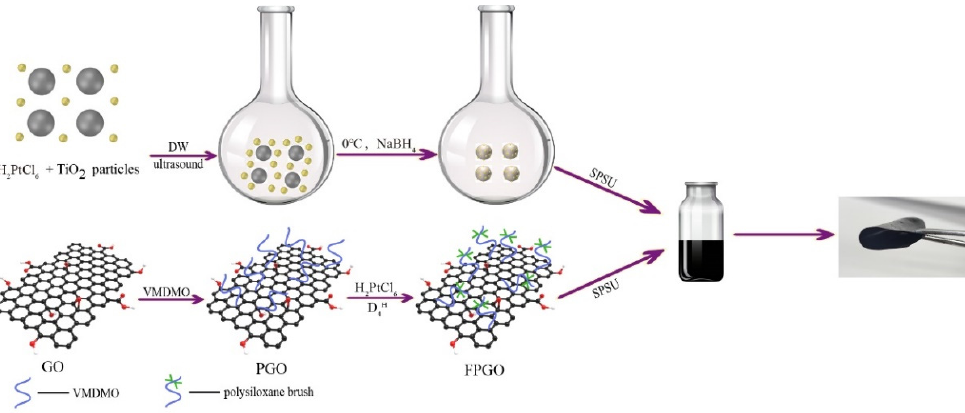
Figure 2. Schematic illustration of the fabrication process for Pt-TiO 2 /FPGO/SPSU nanocomposite PEM.